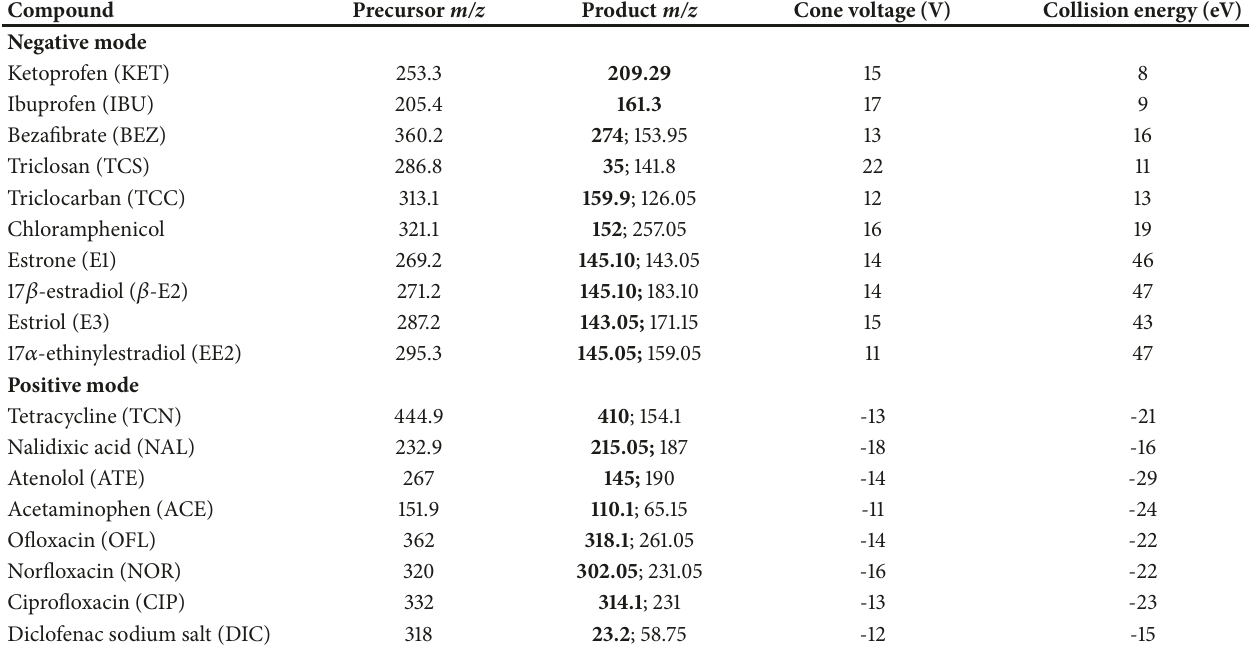
Table 3: Mass spectrometry parameters for pharmaceutical and hormone analysis (quantitative ion marked in bold ; confirmation